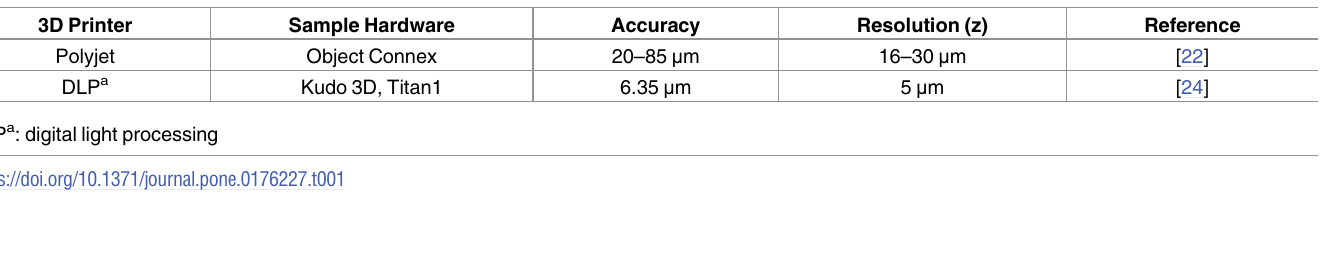
Table 1. The characteristics of the Polyjet and digital light projection (DLP) 3D